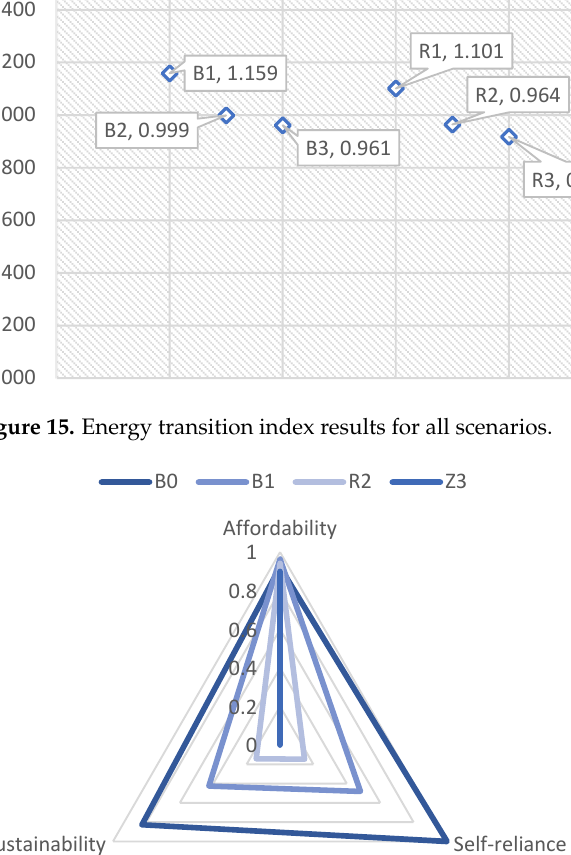
Figure 15. Energy transition index results for all scenarios.